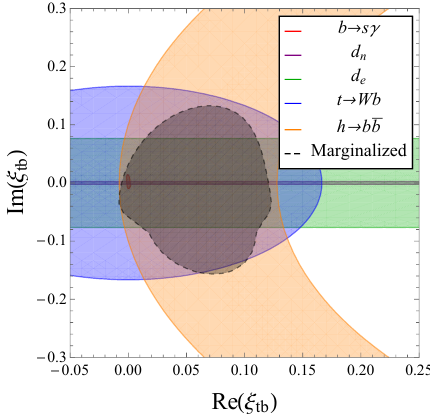
Figure 19 . The (cid:12)gure shows the constraints in the Re (cid:24) tb (cid:0) Im (cid:24) tb plane. The constraints from b ! s(cid:13) , d n , d e , the helicity fractions, and h ! b (cid:22) b are shown in red, purple, green, blue, and orange, respectively, and assume that only (cid:24) tb is generated at the scale (cid:3). The dashed black line is the resulting constraint when marginalizing over the other tb